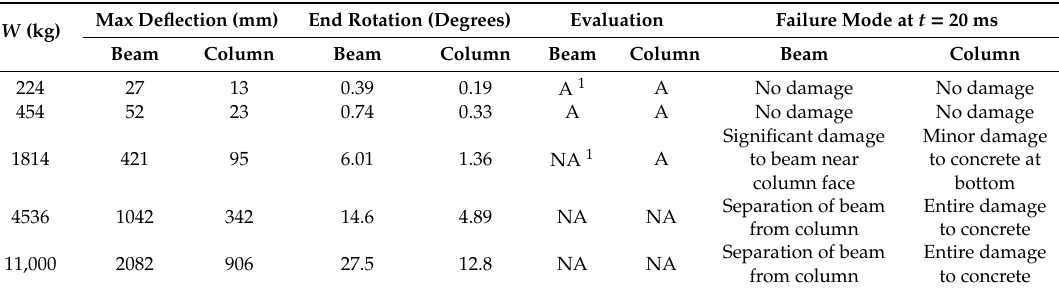
Table 3. Through-diaphragm large CFT connection.